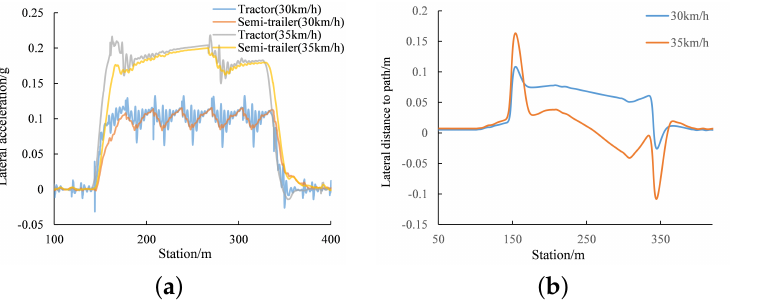
Figure 9. ( a ) Lateral acceleration and ( b ) lateral displacement of tractor-trailer for wind speeds of 62 km/h.